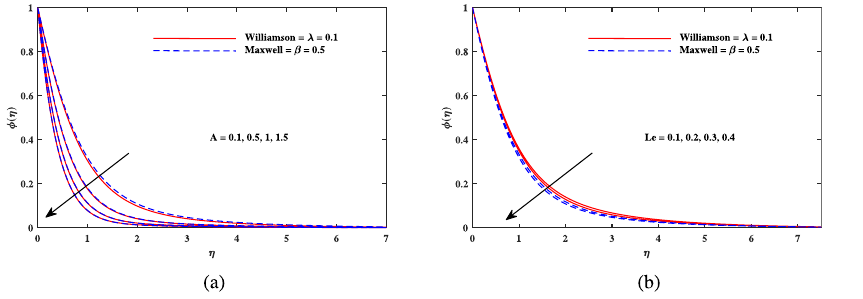
Figure 7. Concentration φ(η) fluctuation with ( a ) A and ( b ) Le .